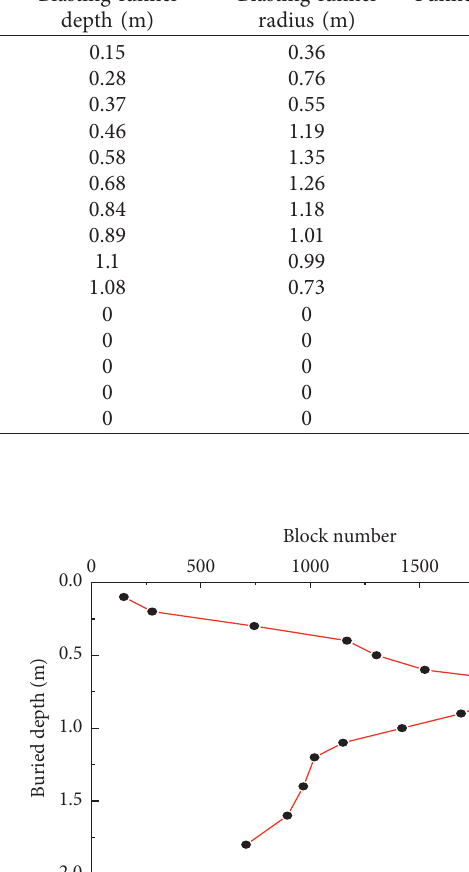
Figure 12: Number of generated blocks – depth of burial of explosive